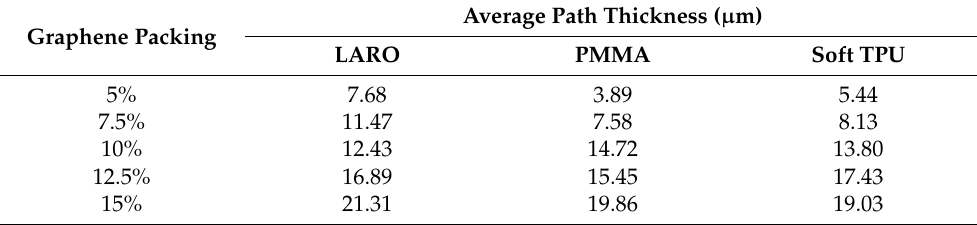
Table 2. Path thickness of all printed paths.